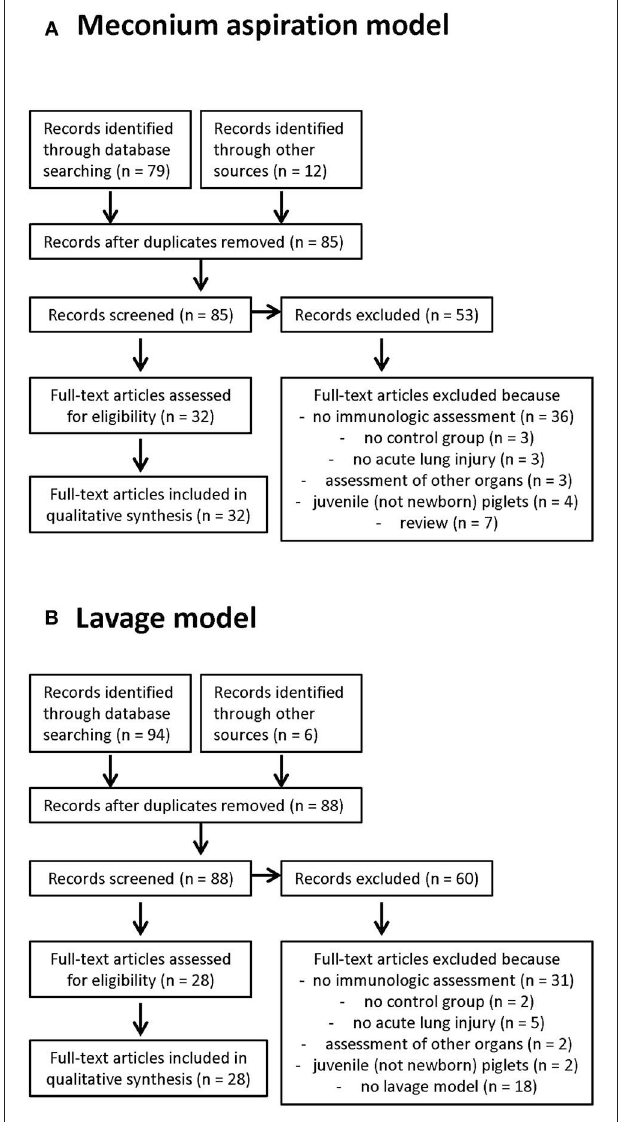
FIGURE 2 | Flow sheets of the systematic review of the meconium aspiration model (A) and the lavage model (B)